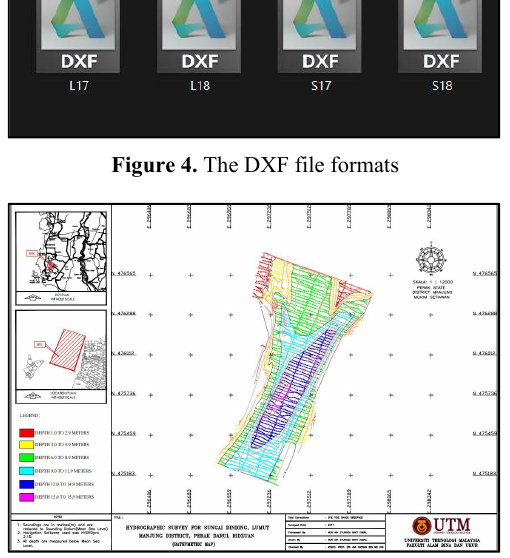
Figure 5. A complete bathymetric plan